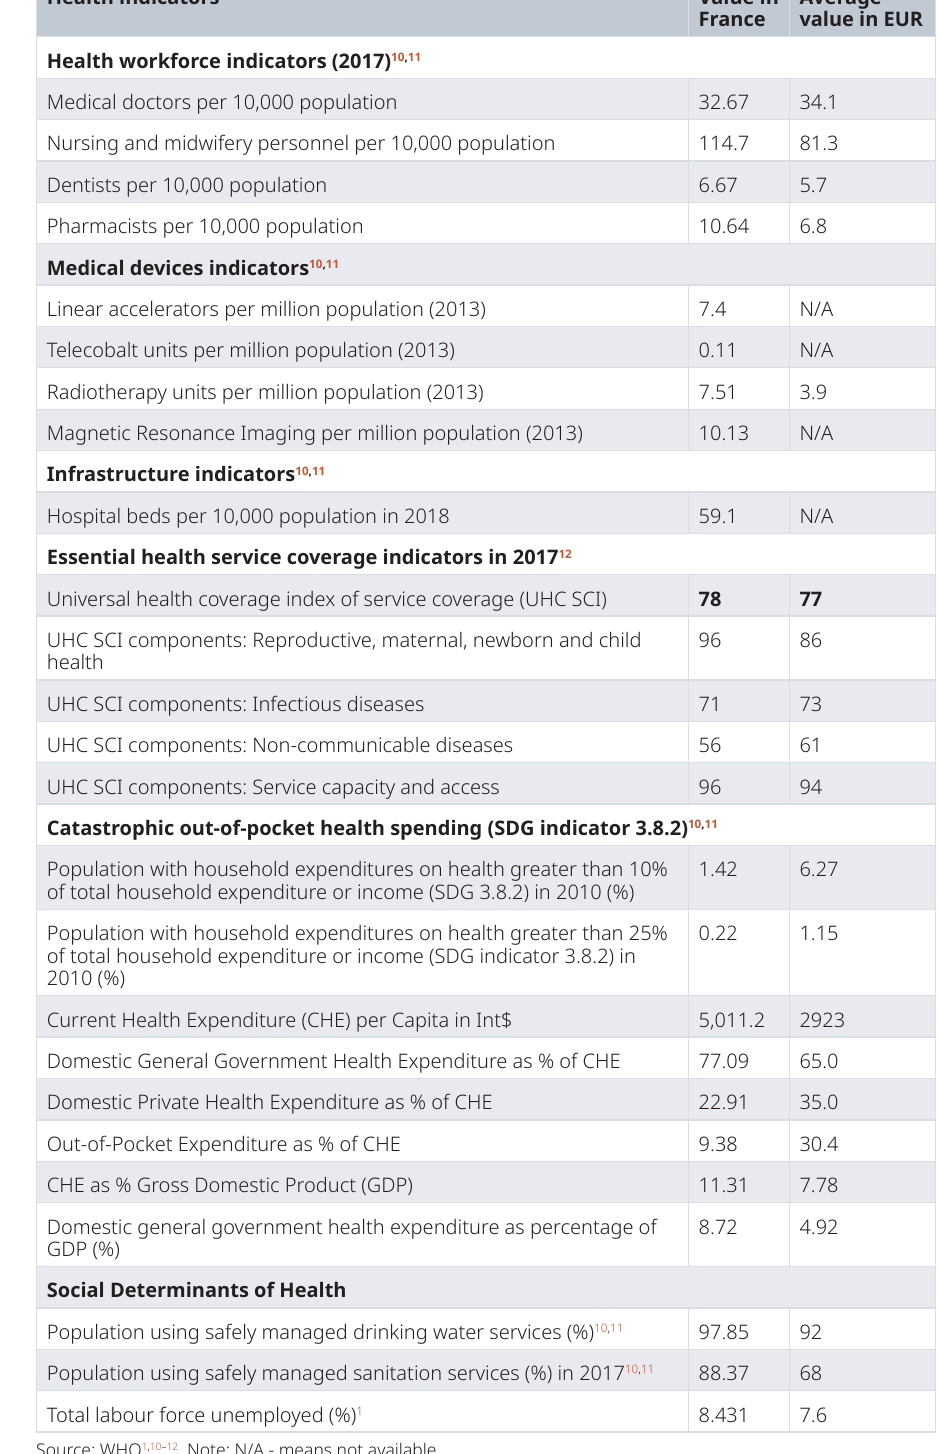
Table 2. Comparison of the health system and social determinants of health indicators in France with the World Health Organization European Region (EUR) averages. Health